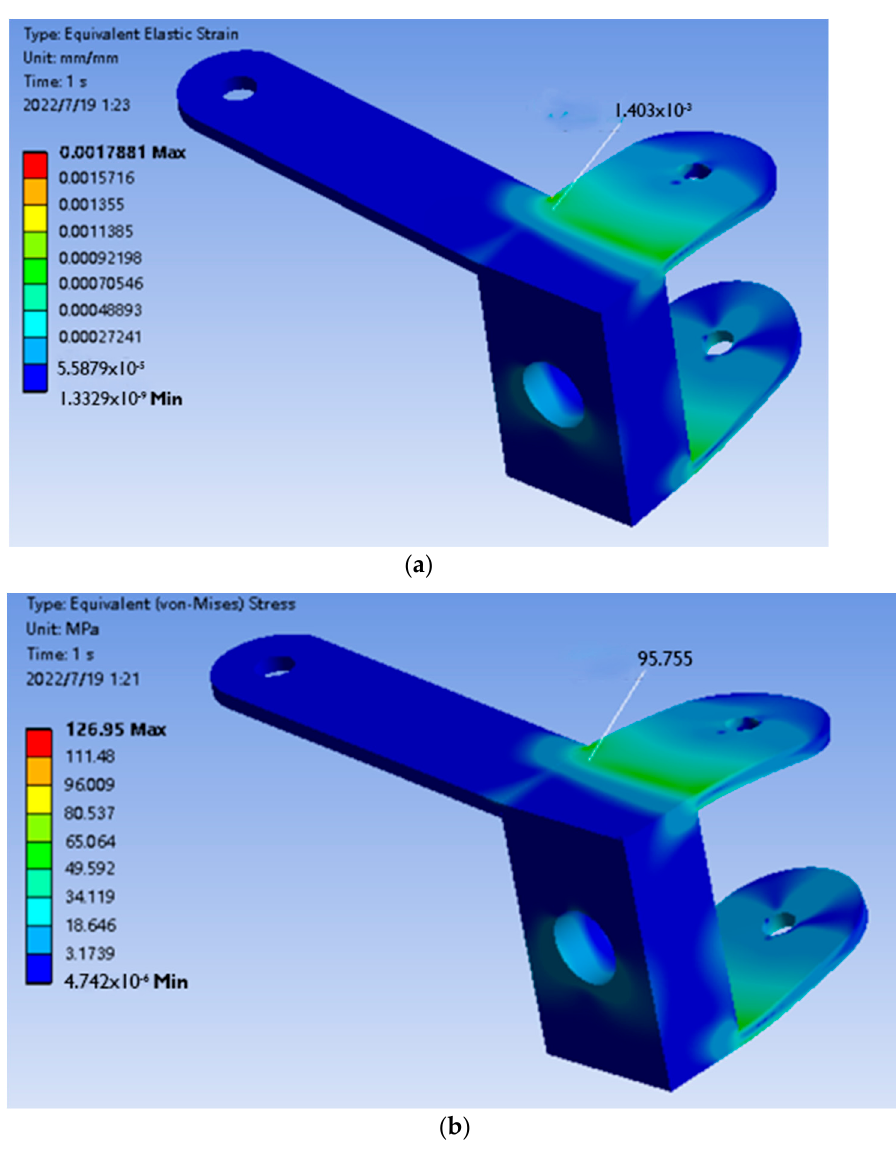
Figure 28. Finite element analysis result graph of front wheel connector. ( a ) Equivalent strain result graph; ( b ) Equivalent stress result graph.